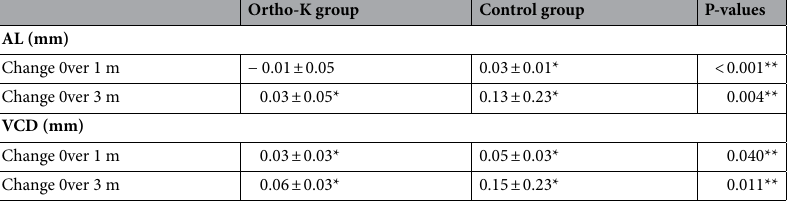
Ortho-K group Control group